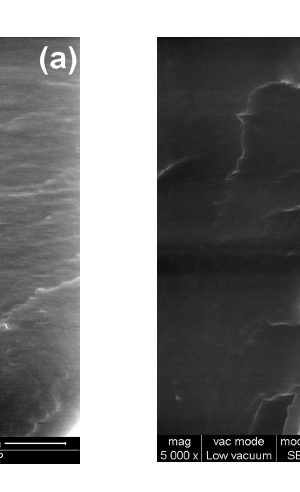
Table 6. TGA results for the thermal degradation of EPDM/butyl rubber composites.